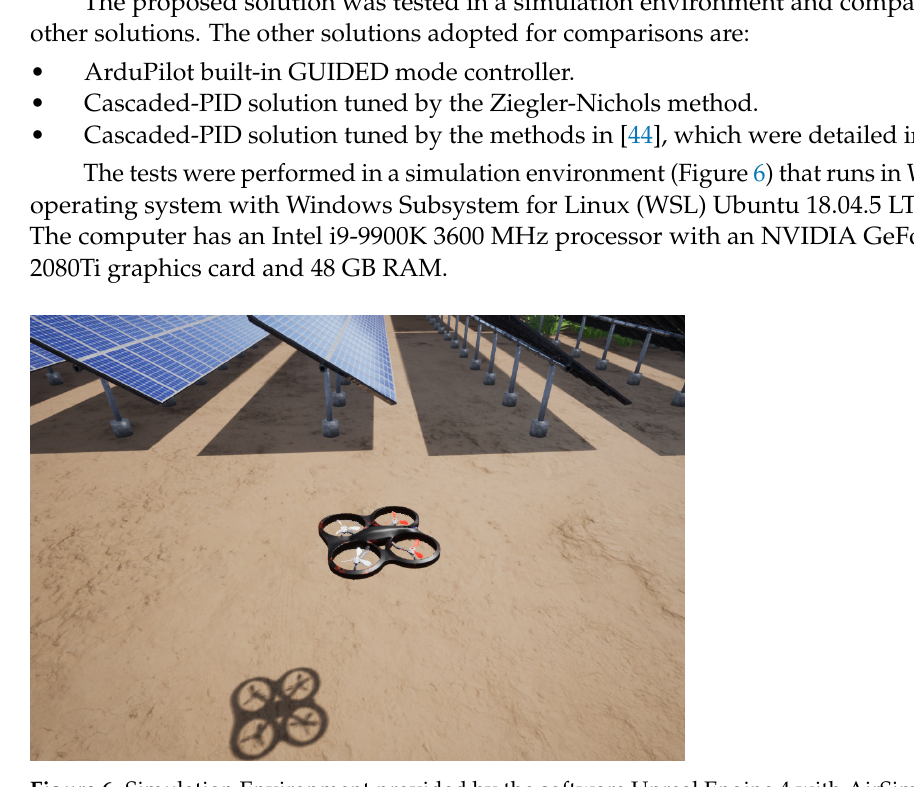
Figure 6. Simulation Environment provided by the software Unreal Engine 4 with